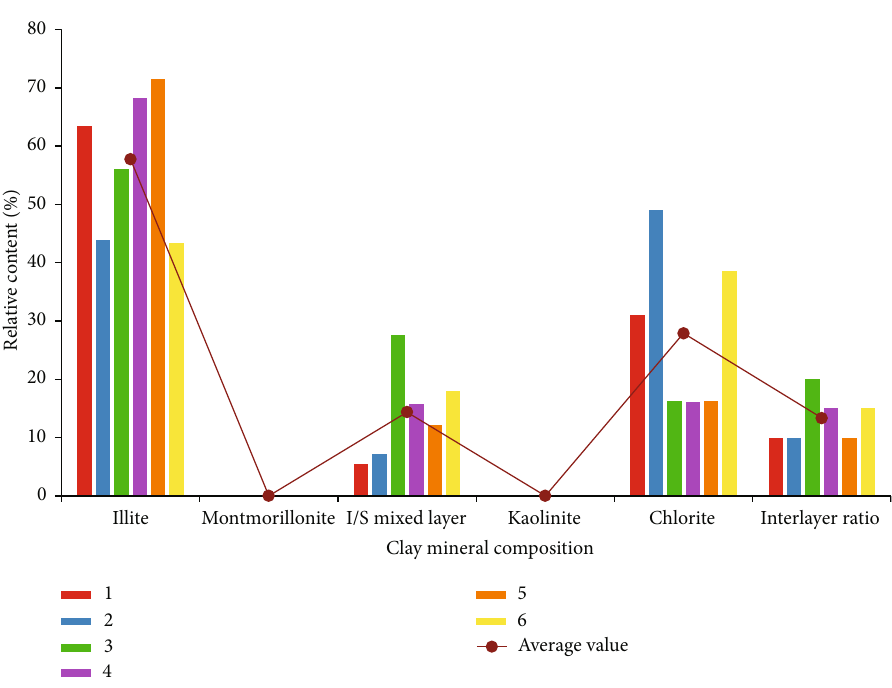
Figure 1: Experimental results of total rock